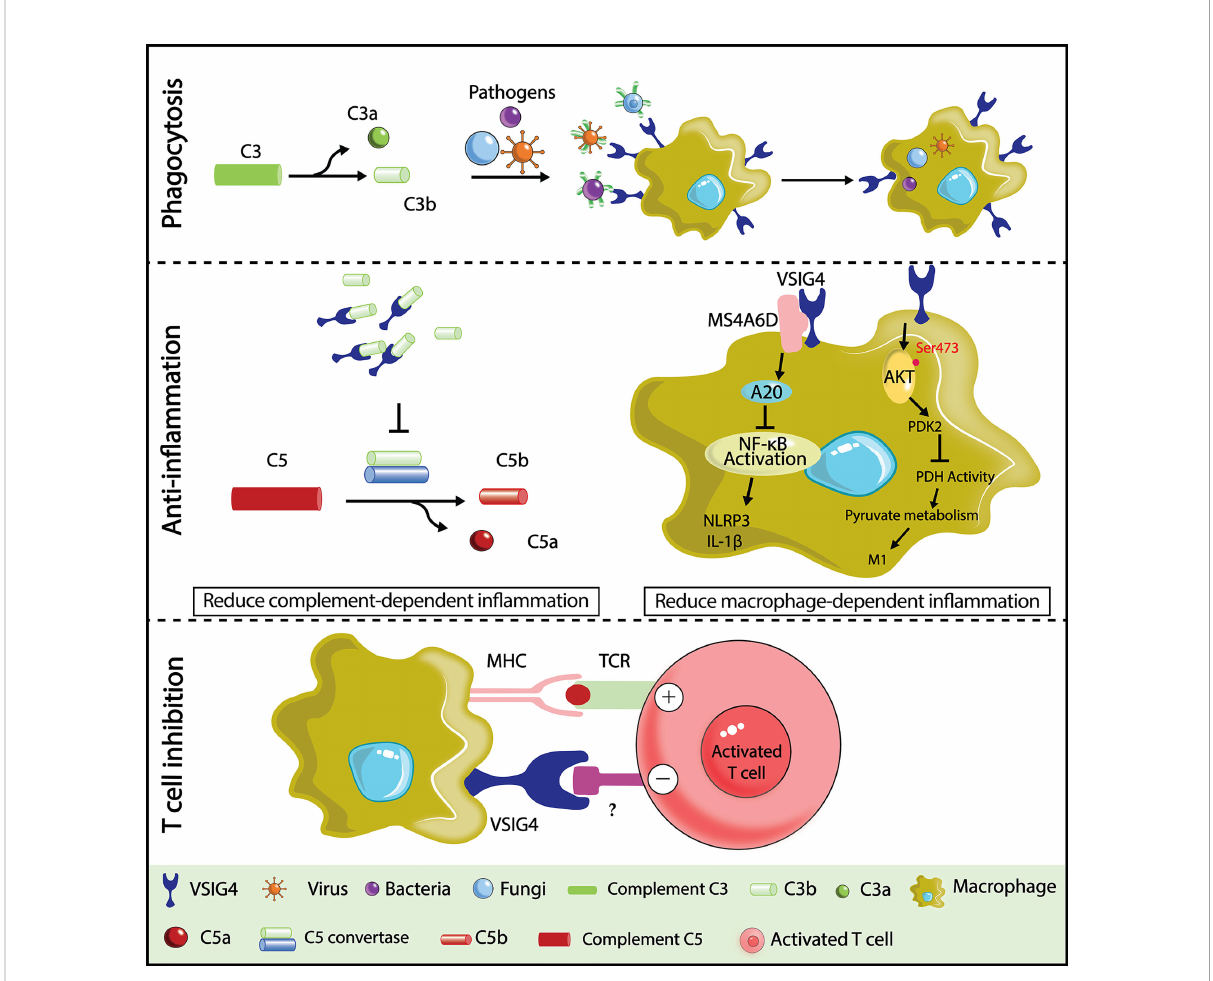
FIGURE 1 Illustration of VSIG4 functions. In host defense against bloodstream infections,VSIG4 recognizes C3b and helps macrophages phagocytose C3b- or iC3b-tagged pathogens (bacteria, viruses, fungi, etc.). In a variety of complement activation-dependent in fl ammatory diseases, VSIG4 delivers anti-in fl ammatory signals by binding C3b to prevent the alternative pathway of complement activation. VSIG4 also inhibits macrophage M1 activation by regulating in fl ammasome activation and pyruvate metabolism. VSIG4 also inhibits T-cell activation, proliferation, and IL-2 production upon binding to an unknown ligand on T